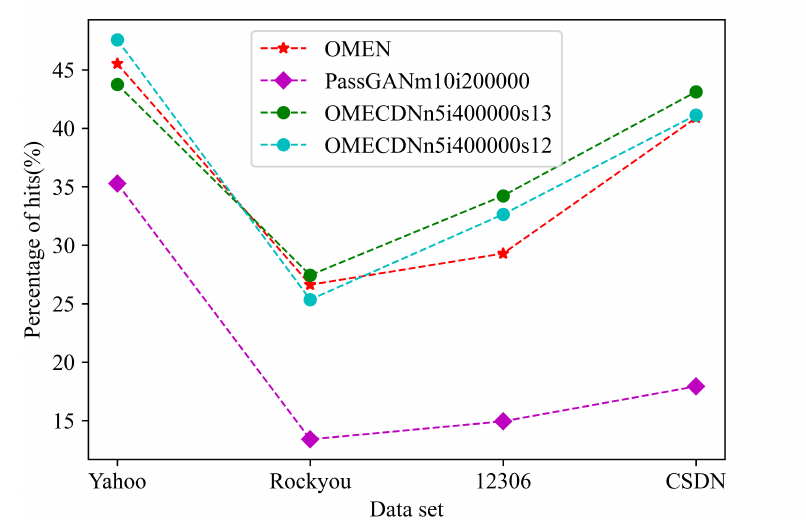
Figure 7. The hit rate amounts of the three hit models for four